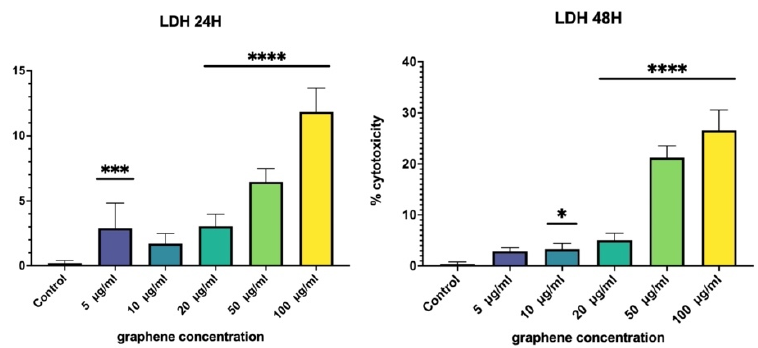
Figure 2. Cytotoxicity of nanomaterials determined by LDH analysis. The cytotoxicity level increased with longer exposure to the GPs. Data are presented as a percentage (%) of untreated control (0 μ g/mL) and are visualized as mean ± standard deviation. * p -value < 0.05; *** p -value < 0.001; **** p -value < 0.0001.